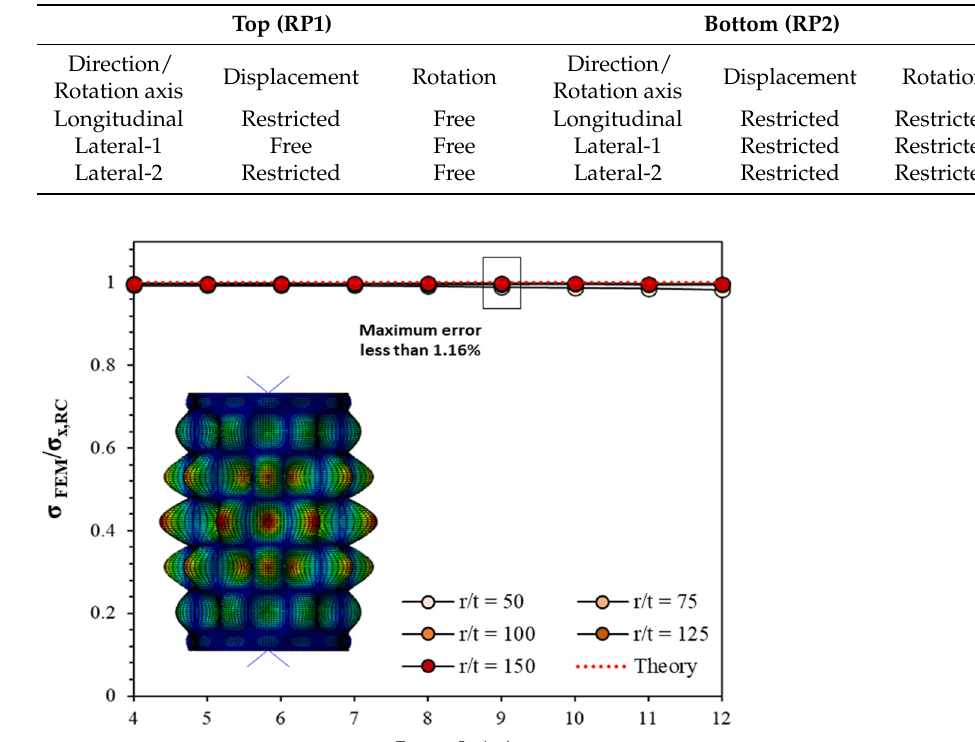
Table 4. Boundary conditions.